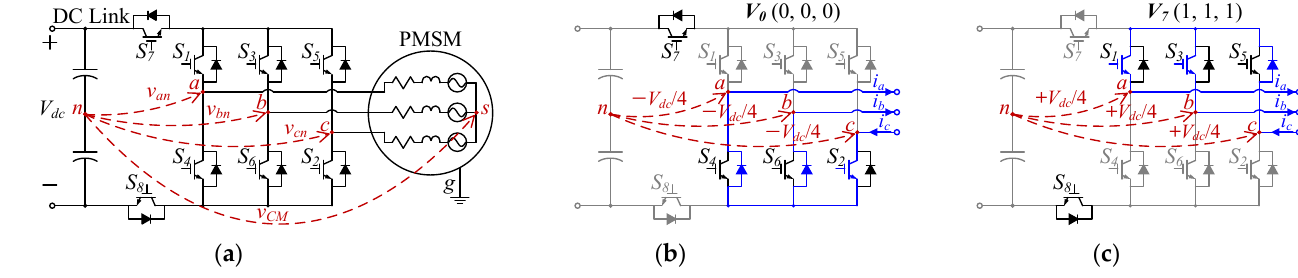
Figure 2. Conventional CMC reduction methods: ( a ) MRSPWM; ( b ) MRSPWM with overmodulation method; ( c ) HMSPWM.